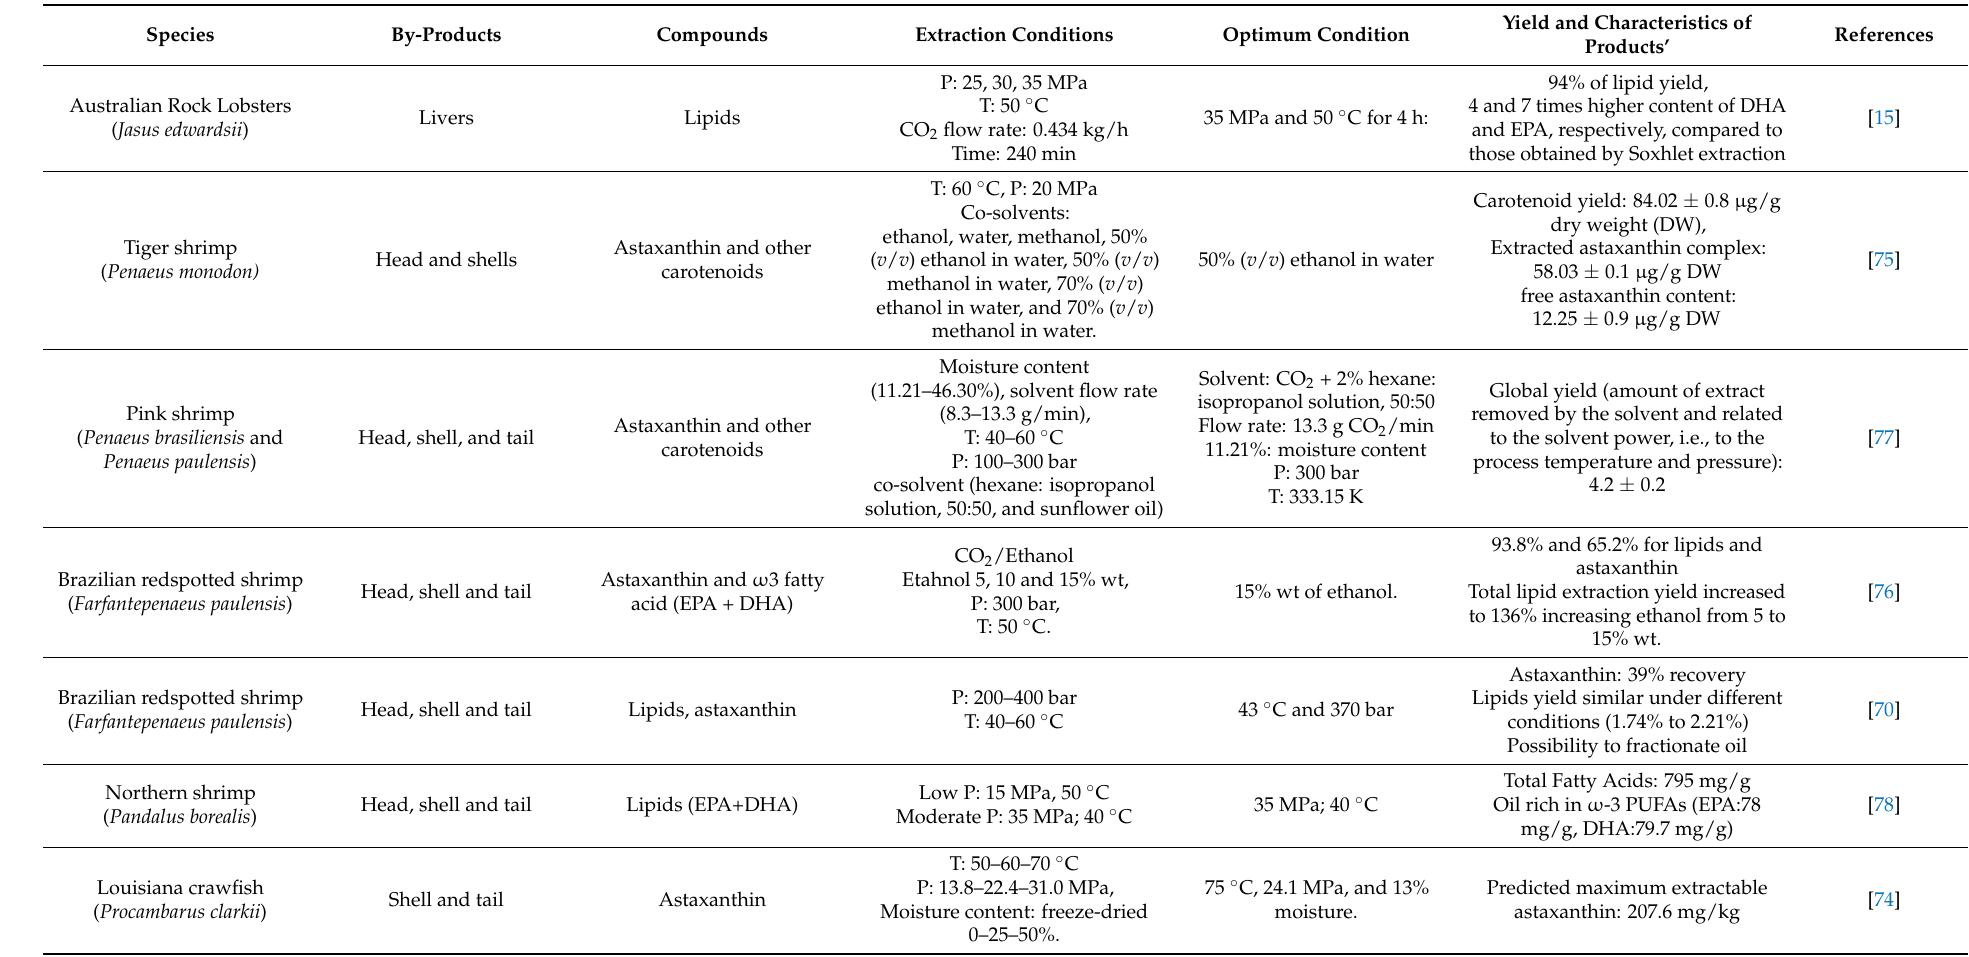
Table 1. Supercritical fluid extraction (SFE) of crustacean by-products for the recovery of valuable